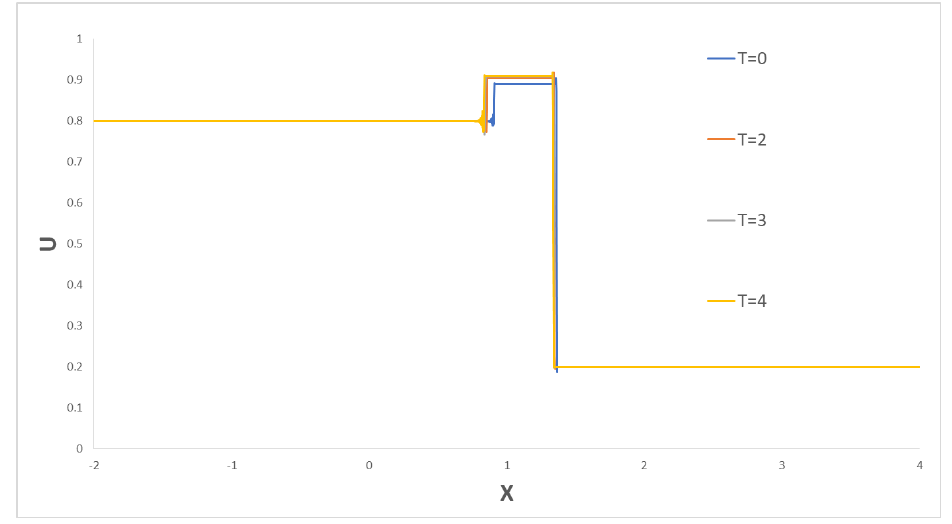
Figure 15. Saturation as a function of velocity for various values of the characteristic times τ (the same example as that described in Figure 13a for M =